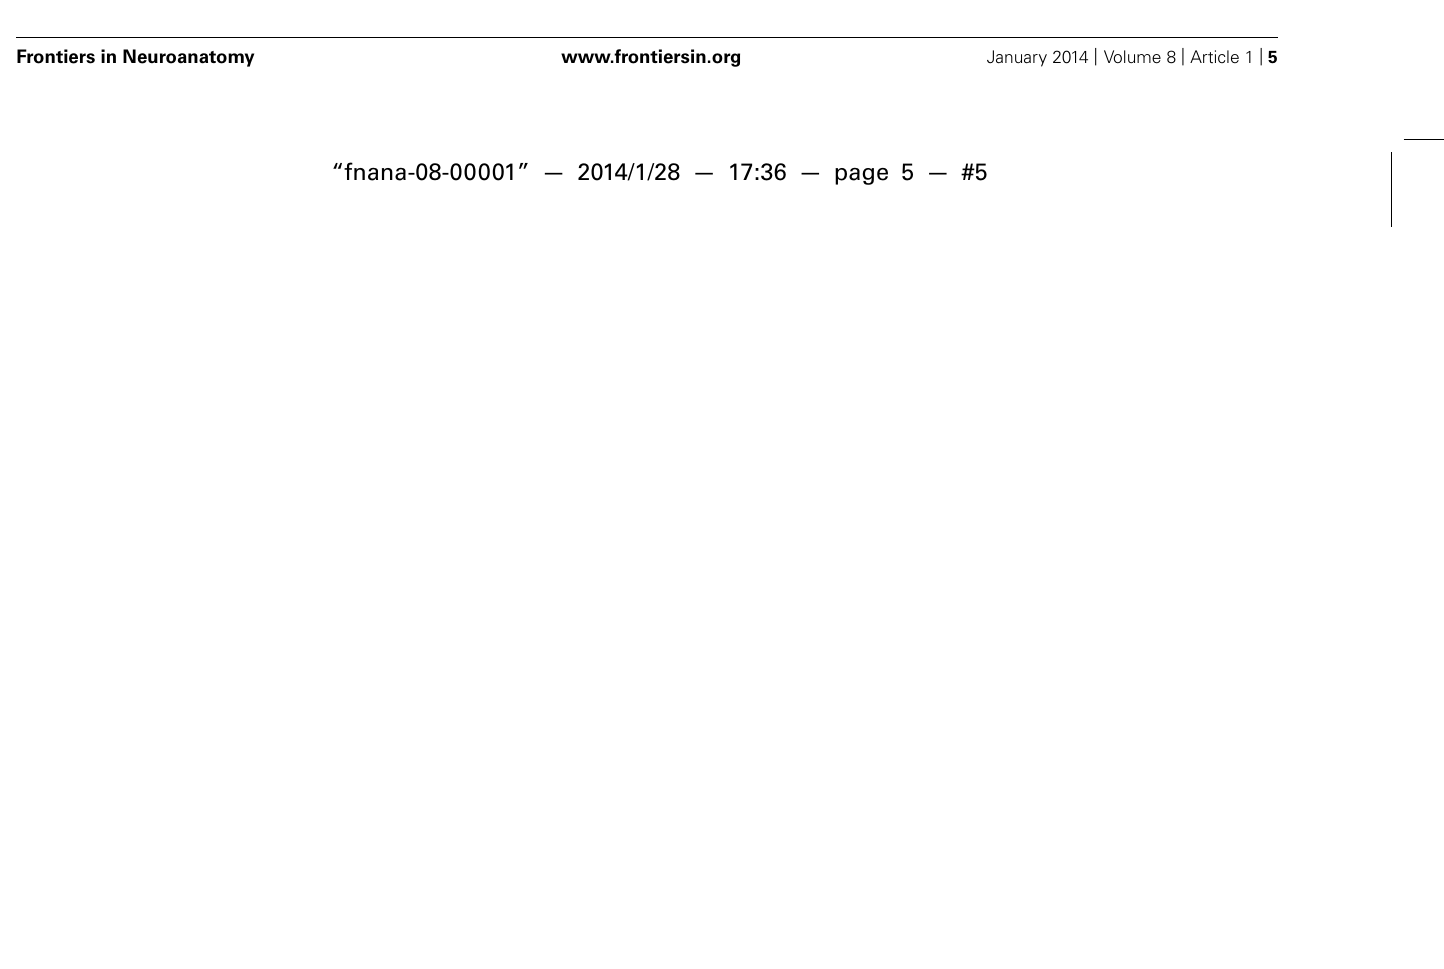
FIGURE 2 | (Left) Cajal’s scheme showing the flow of current (arrows) in the visual and olfactory systems to support the Law of Dynamic Polarization. This drawing was reproduced in his article Significación fisiológica de las expansiones protoplásmicas y nerviosas de las células de la substancia gris (Rev. Ciencias Méd., 22: 673–679; 715–723, 1891). Fig. 1. Scheme of cellular connections in the olfactory mucosa, olfactory bulb, tractus, and olfactory lobe of the cerebrum. The arrows indicate the direction of the currents. A , olfactory bulb; B , mucosa; C , olfactory lobe. a, b, c, d . One-way or centripetal pathway through which sensory or olfactory excitation passes. e, f, g, Centrifugal pathway through which the [nervous] centres can act on the elements of the bulb, granules and nerve cells, whose protoplasmic processes penetrate the glomeruli. Fig. 2. Scheme of the visual excitation pathway through the retina, optic nerve and optic lobe of the birds. A , retina; B , optic lobe. a, b, c, represent a cone, a bipolar cell and a ganglion